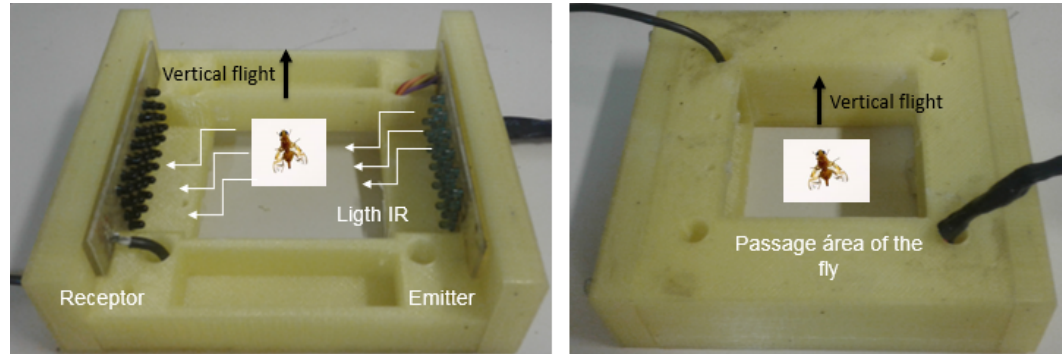
Figure 3. Optoelectronic sensor base with emitter and receiver circuits ( left ) and optoelectronic sensor ready for use ( right ).